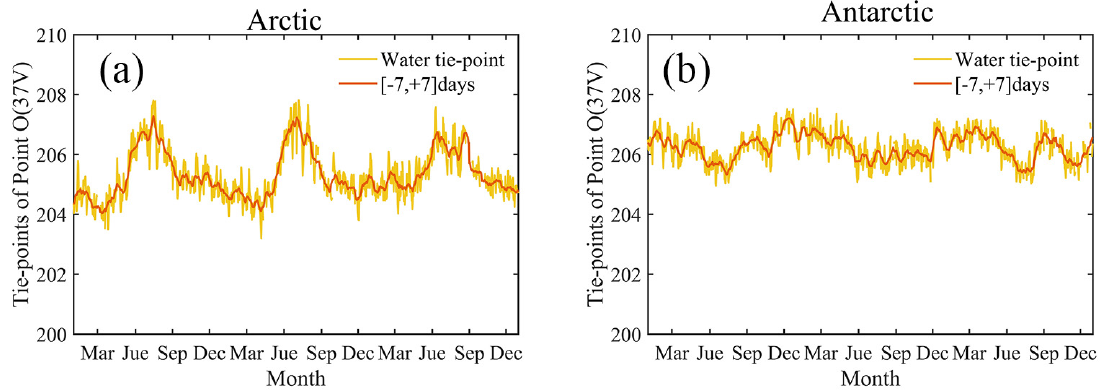
Figure 5. Daily HY-2B SMR bootstrap algorithm tie-points T O for open water (orange line) and [ − 7, +7] day interval results (red line) during 2019–2021. The ( a ) diagram indicates the Arctic and the ( b ) diagram indicates the